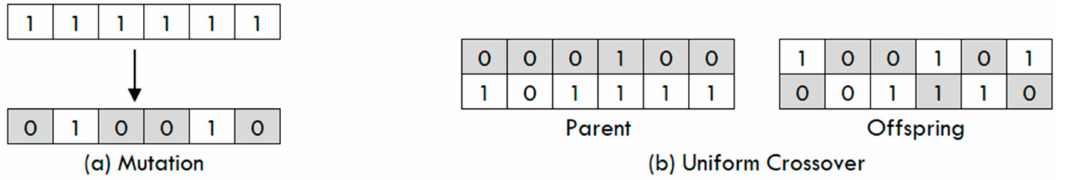
Figure 3. Mutation and crossover